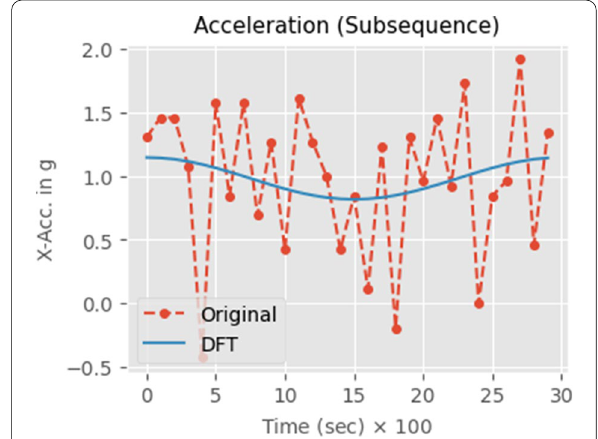
Fig. 4 Low‑pass filtering and smoothing of a sample of acceleration in x‑axis upon Discrete Fourier Transform (DFT). In this plot, DFT result is obtained by taking only first two Fourier